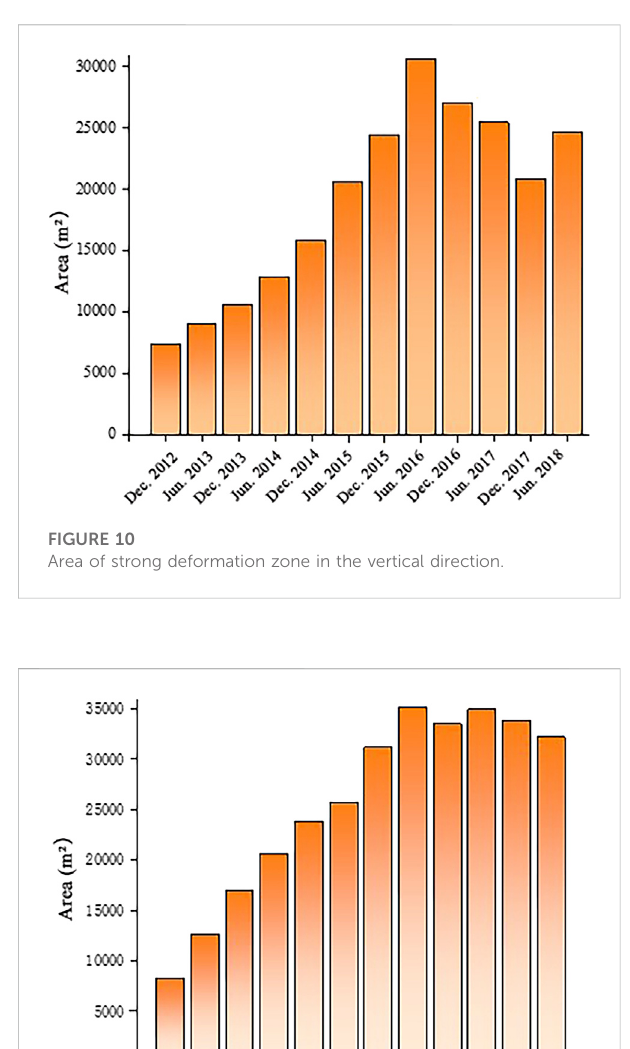
FIGURE 11 Spatialandtemporalevolutionnephogramoftotaldisplacement.